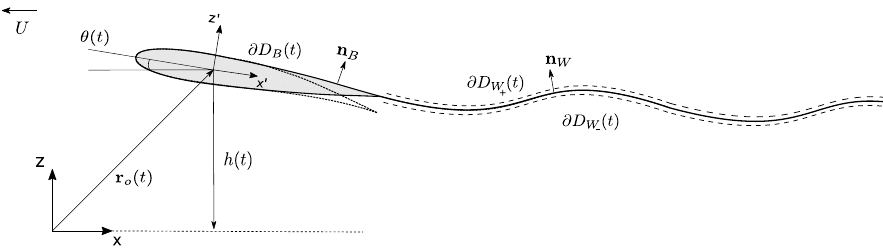
Figure 2. Unsteady hydrodynamics notation for the chord-wise flexible flapping foil, introducing the inertial and body-fixed coordinate systems for the hydrodynamics problem formulation.